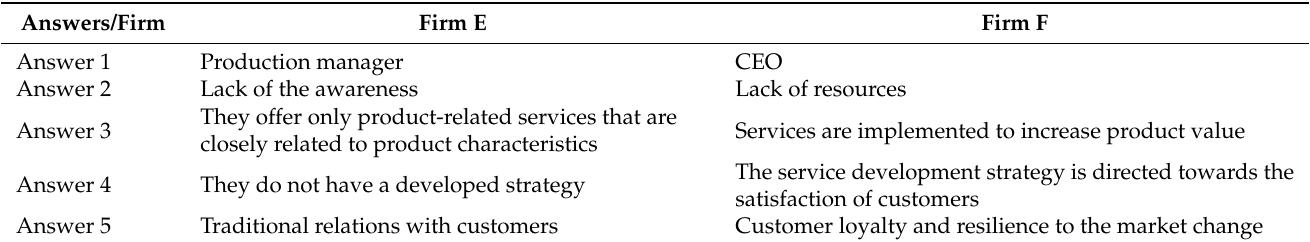
Table 8. Interviews with representatives from high-tech